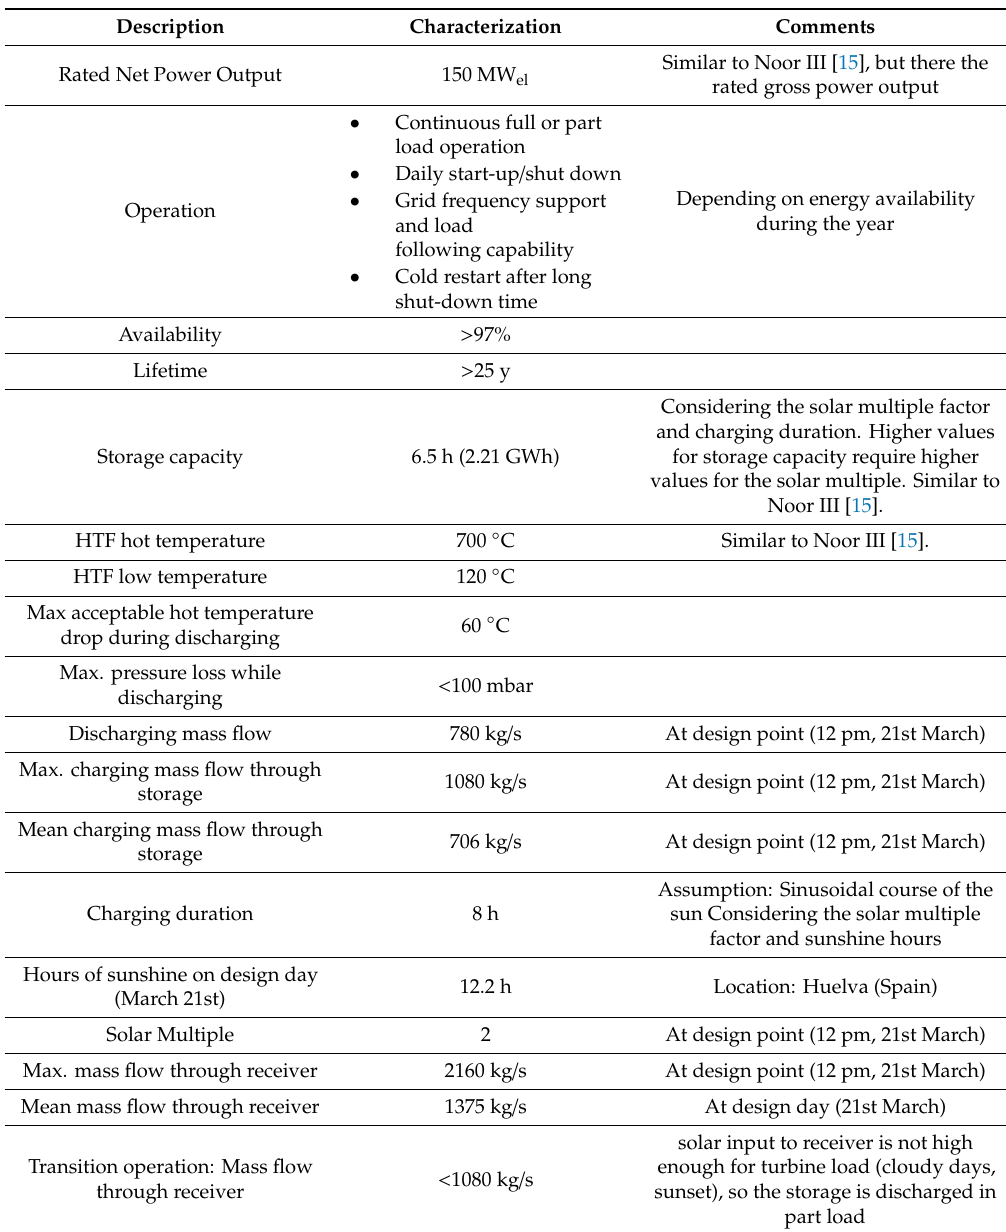
Table 1. Target specification for full-scale CSP plant